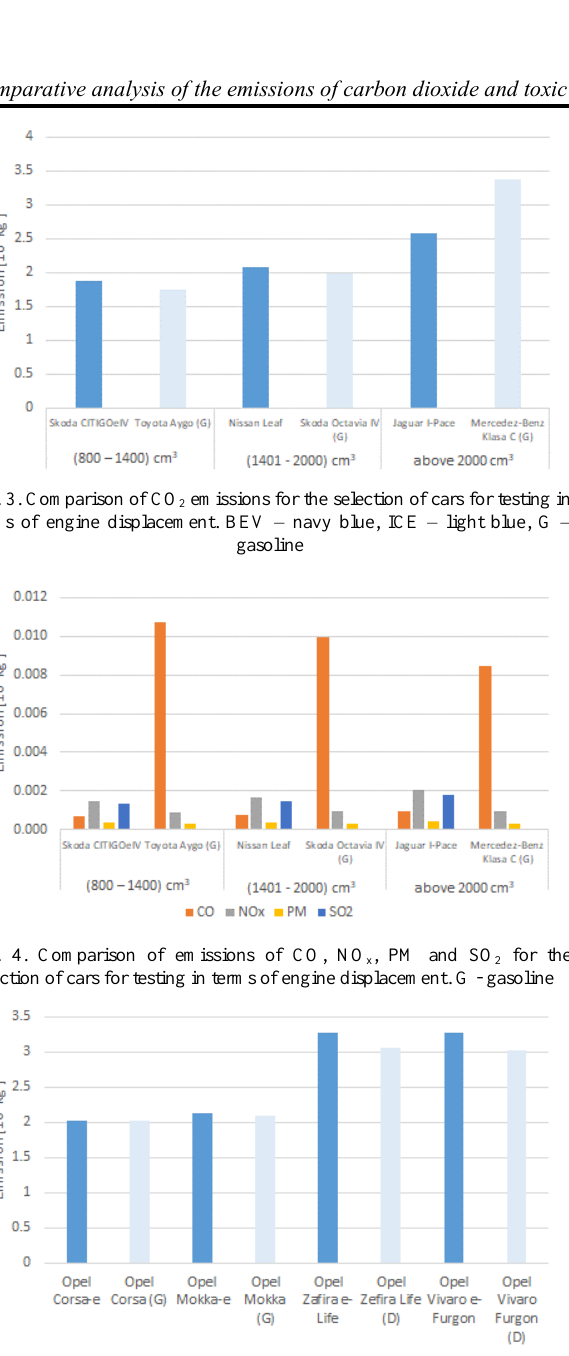
Fig. 5. Comparison of CO 2 emissions of selecting vehicles for testing because of the brand of vehicle. BEV – navy blue, ICE – light blue, G – gasoline, D – diesel